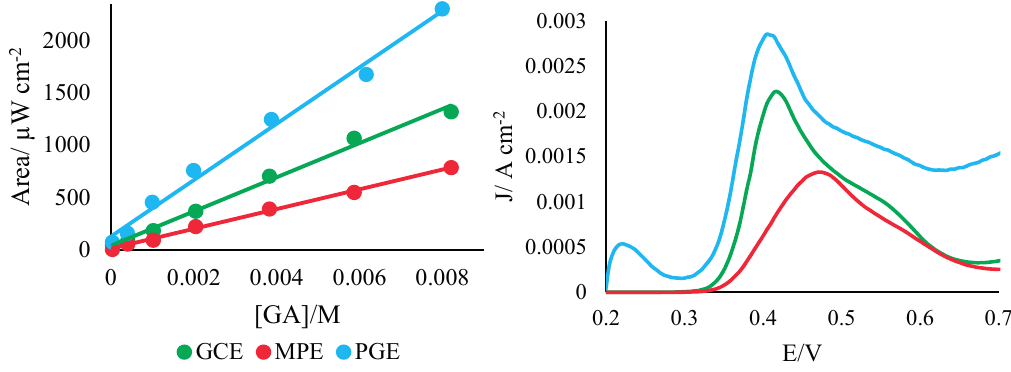
Figure 2. Characterization of PGEs in gallic acid standards. Left : calibration curves for voltammograms of electrodes in gallic acid (2 × 10 − 3 M). To account for differences in exposed area, current is given as a function of raw current divided by electrode surface area. Table 2. Validation parameters for PGEs. Parameters derived from calibration curve